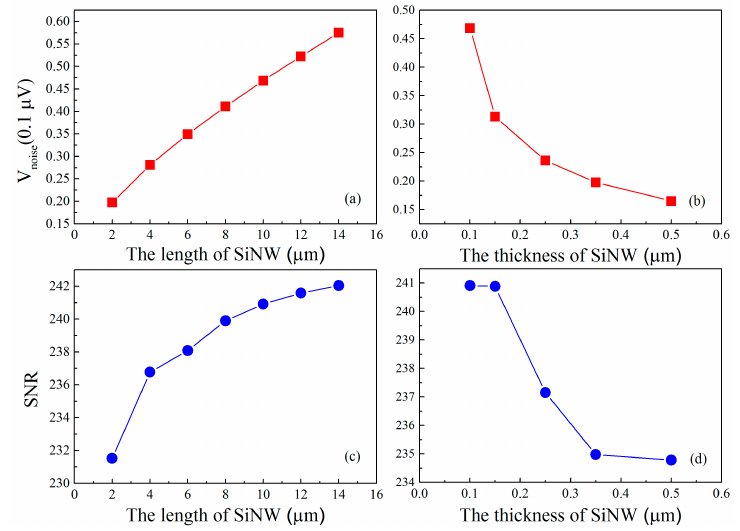
Figure 6. ( a ) Variation of the voltage noise with the length of SiNW; ( b ) variation of the voltage noise with the thickness of SiNW; ( c ) variation of SNR with the length of SiNW; and ( d ) variation of SNR with the thickness of SiNW.